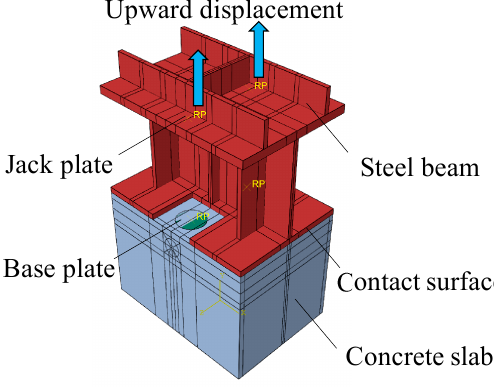
Figure 7. Finite element model.